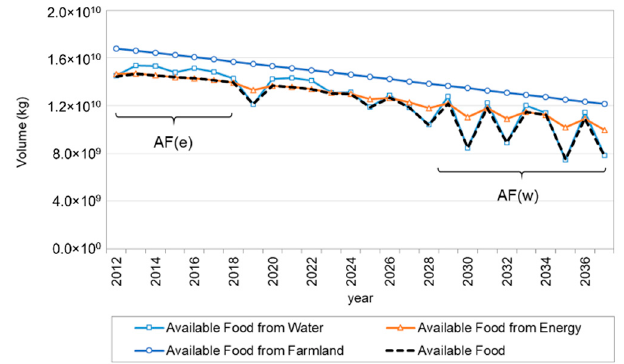
Figure 10. Critical factors affecting food production in Group 2.